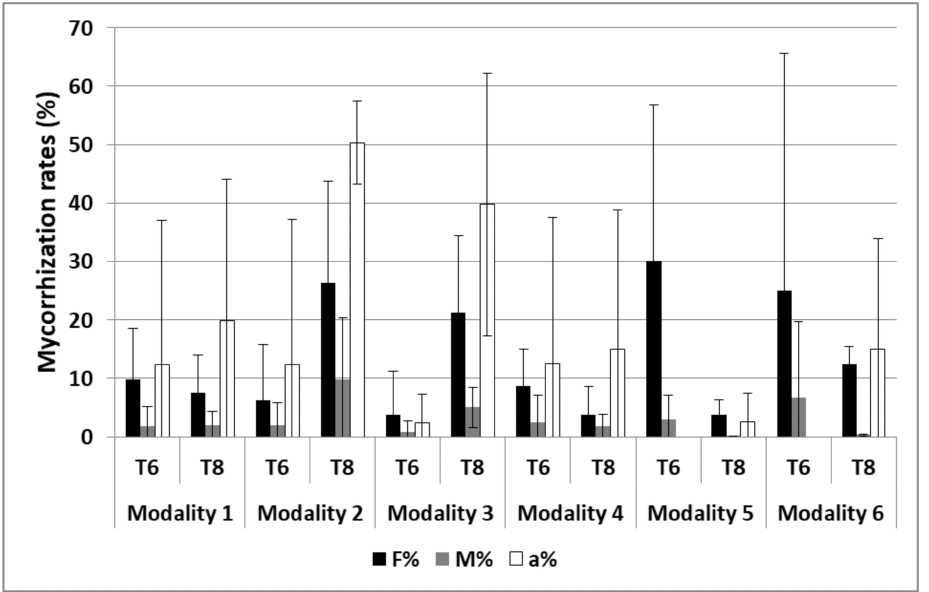
Figure 5. Mycorrhization rates (F%, M%, and a%) for plants of modalities 1 to 6 at week 6 (T6) and week 8 (T8) after planting independently of the substrates. F% (in black) corresponds to the percentage of roots with AMF structures; M% (in grey) corresponds to the percentage of colonization inside roots; a% (in white) corresponds to the content in arbuscules of mycorrhized parts. Modality 1 = AMF (strain IP21); modality 2 = AMF (strain IP21) + Trichoderma harzianum ; modality 3 = AMF (strain IP21) + Pseudomonas fluorescens (strain IPB04); modality 4 = AMF (strain IP21) + Trichoderma harzianum + Pseudomonas fluorescens (strain IPB04); modality 5 = commercial AMF product containing 6 AMF strains; modality 6 = commercial AMF product containing 6 AMF strains + Trichoderma